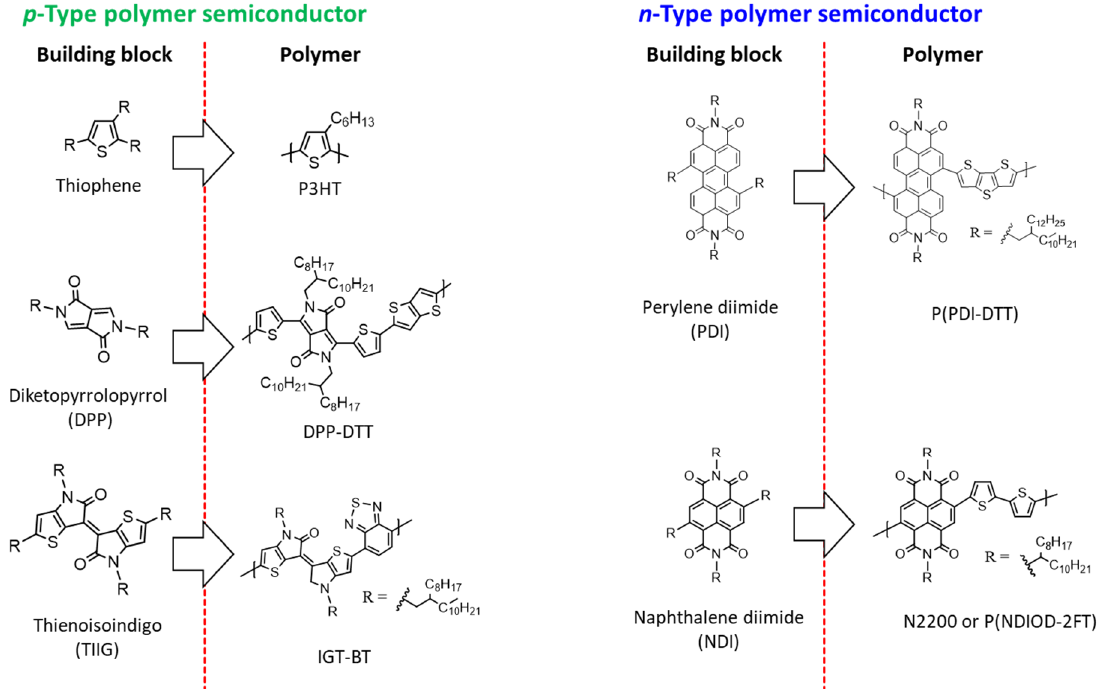
Figure 3. Polymer semiconductors with respect to polarity ( p - and n -type) in biomedical applica- tions.